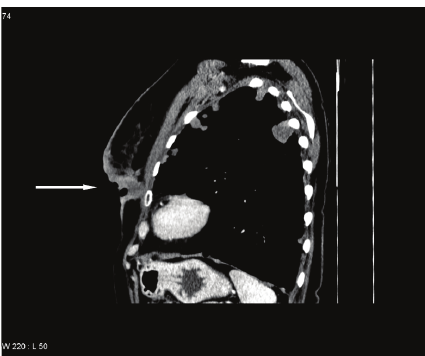
Figure 2: Computed tomography scan of the chest showing multiple bilateral lung metastases.